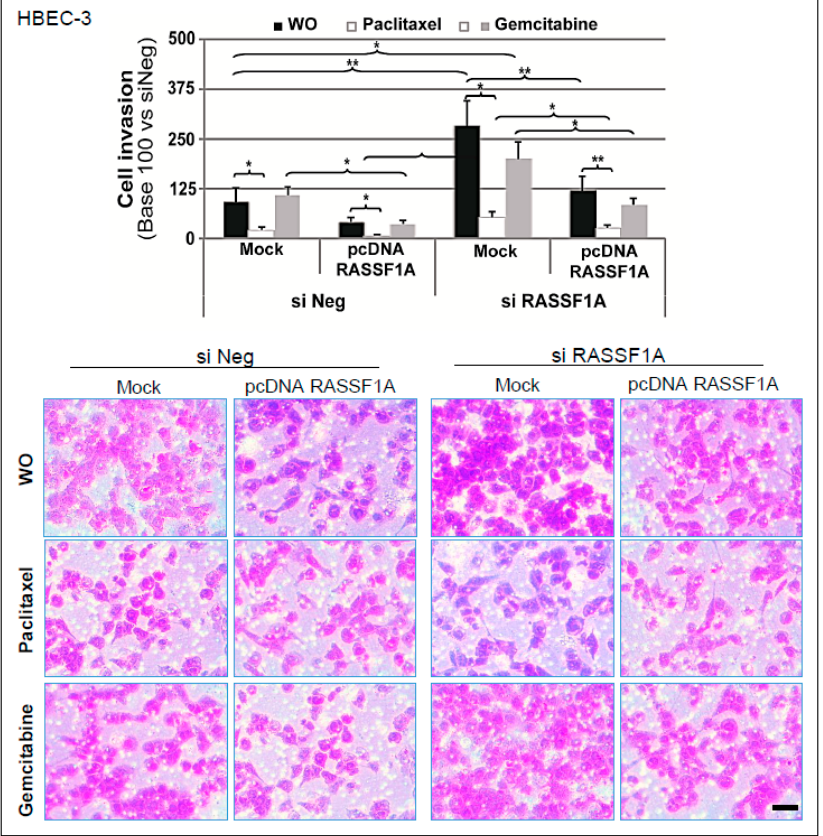
Figure 6. Paclitaxel treatment rescues normal invasion following RASSF1A knockdown. HBEC-3 cells were transiently transfected with siNeg, siRASSF1A, or plasmid coding wild-type RASSF1A. When indicated, 24-h post-transfection cells were treated for a further 24 h with paclitaxel (10 nM) or gemcitabine (250 nM) . The invasion capacity of transfected HBEC-3 cells was measured using Matrigel ® -coated Invasion Transwell. Relative invasion normalized to that of the cells transfected with siNeg. Scale bar: 50 μ m. The data are expressed as the mean ± SEM from three individual experiments. The statistical significance was determined using a Student’s t -test. * p < 0.05; ** p < 0.01.